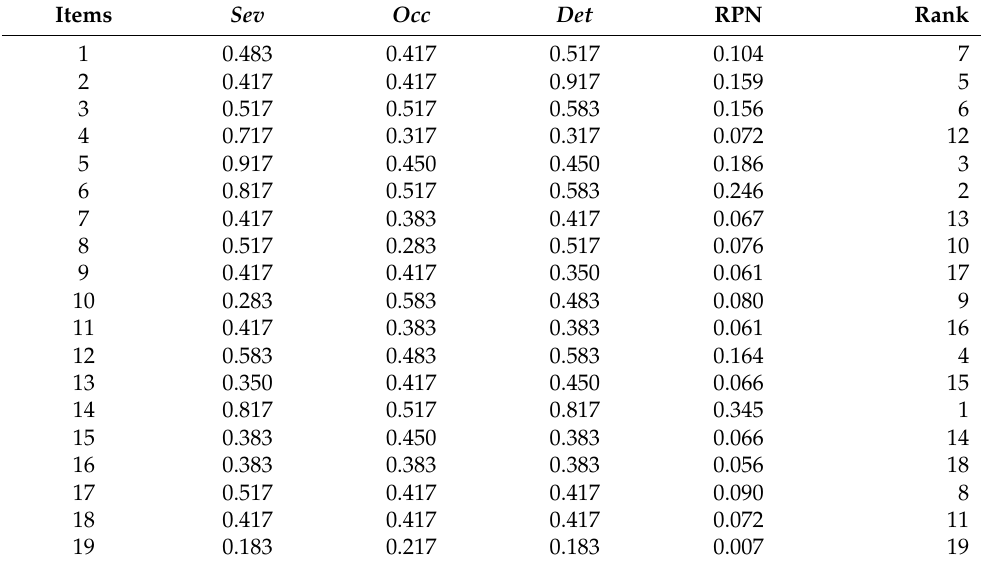
Table 3. The RPN value of the electronic equipment new product design failure.